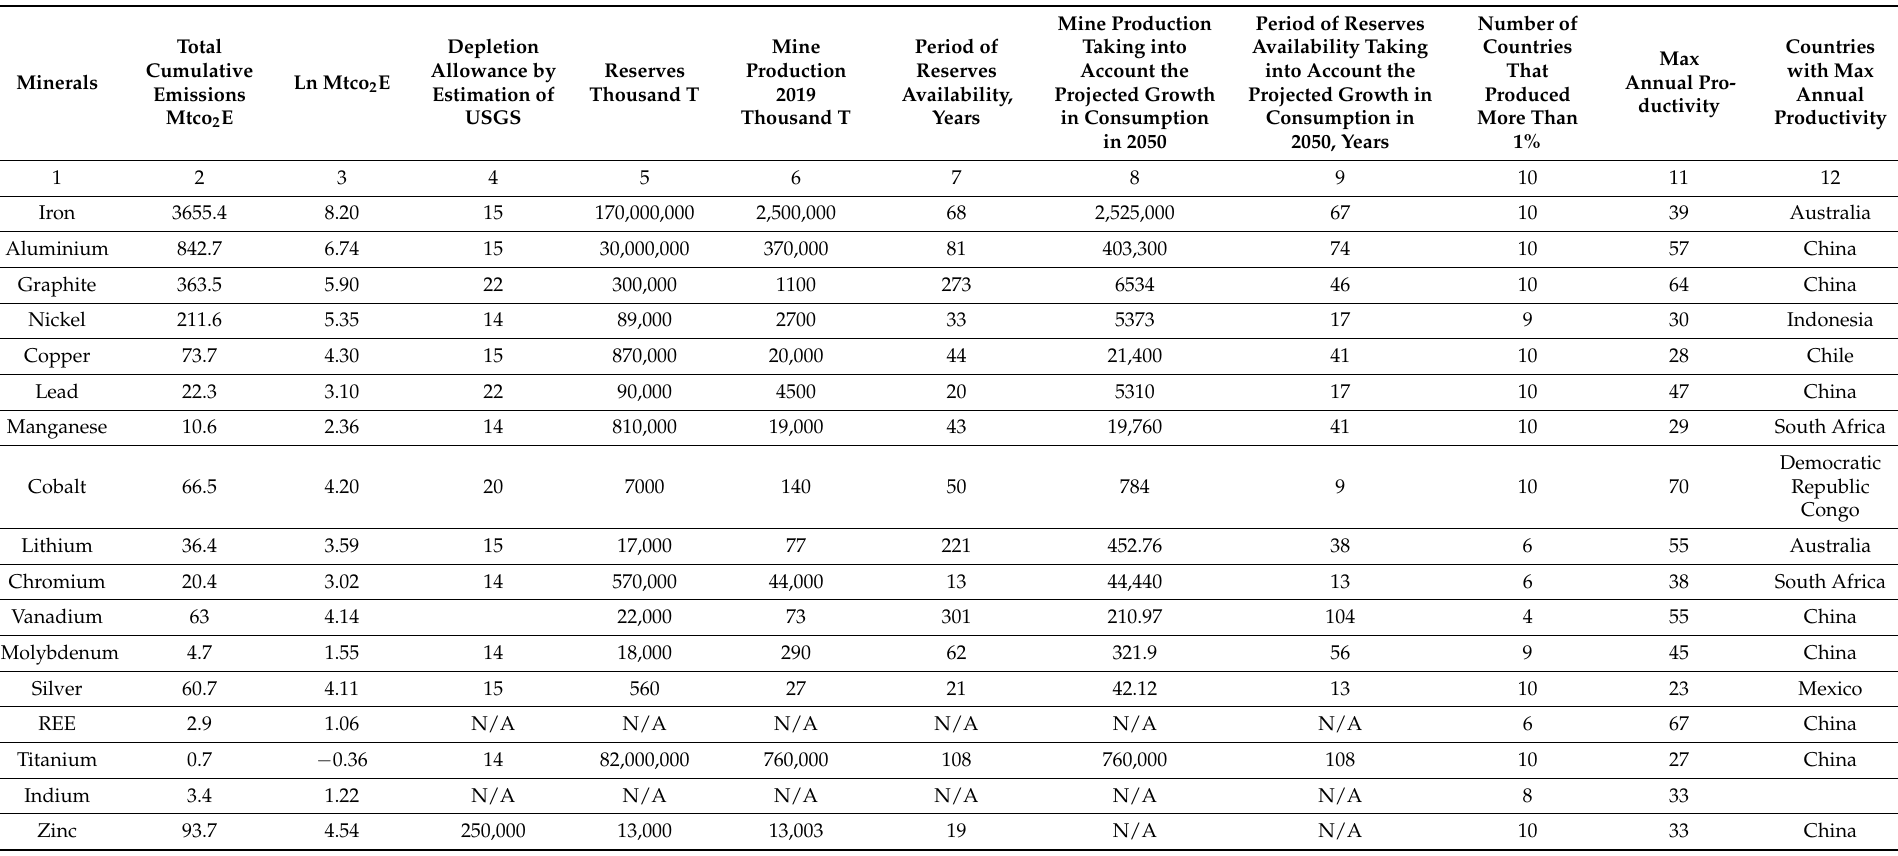
Table 3. Initial data for calculating the availability indices IA4, IA5, IA6 and